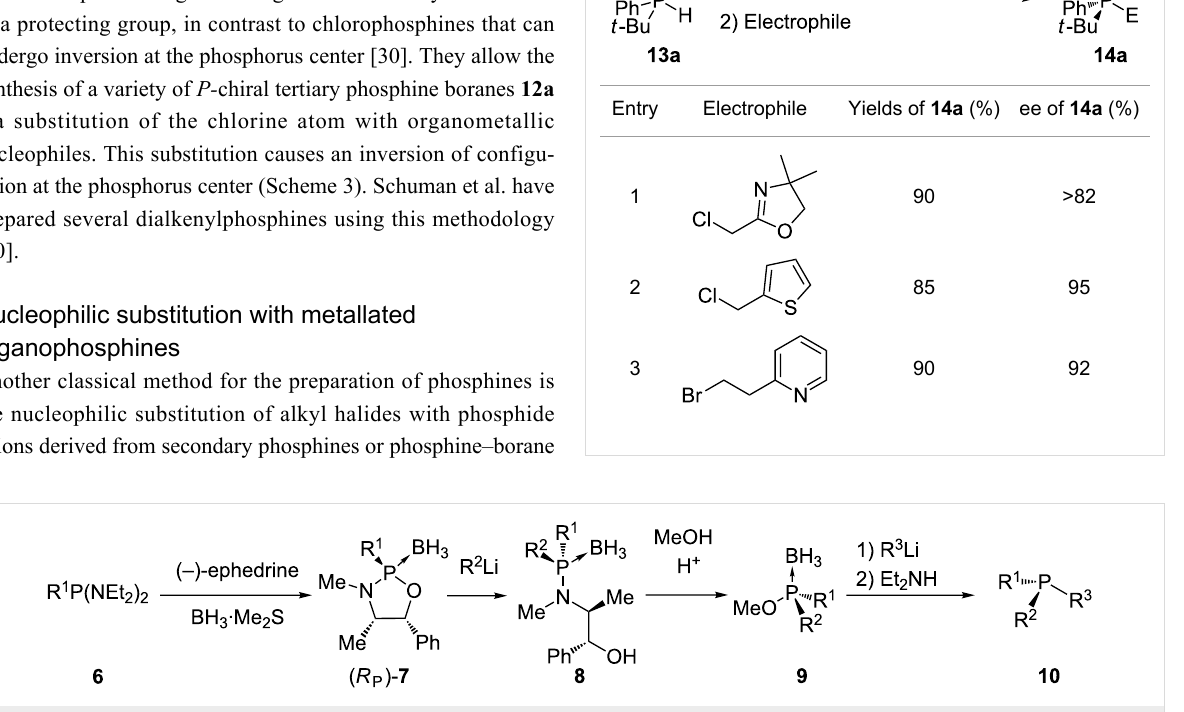
Scheme 2: Enantioselective synthesis of chiral phosphines 10 with ephedrine as a chiral auxiliary.